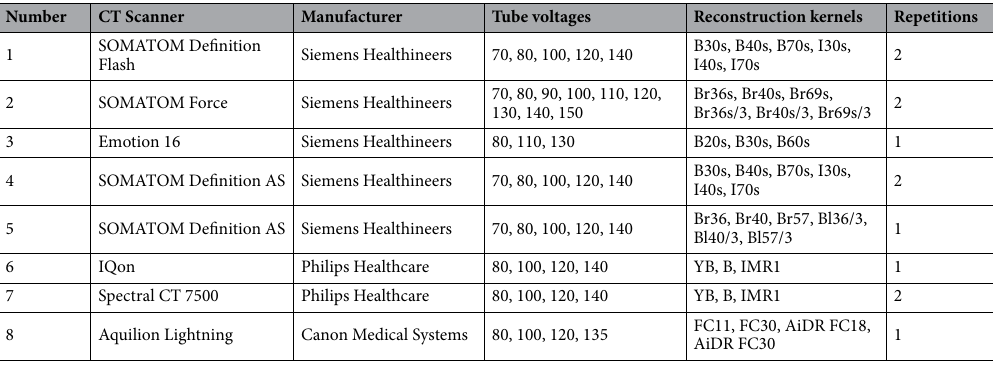
Table 2. Overview of included CT scanners and scan